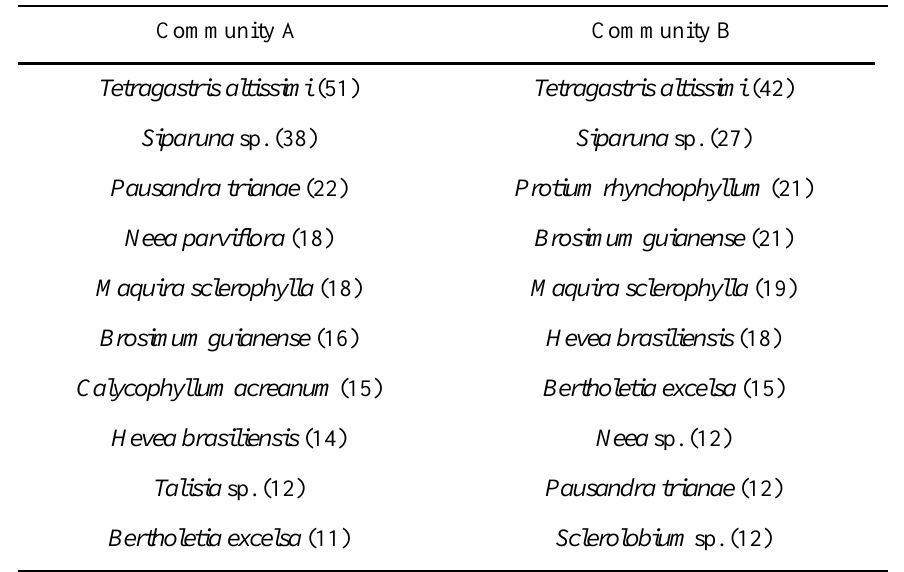
Table 8. The 10 most dominant species found along rubber trails, by frequency. N = 84